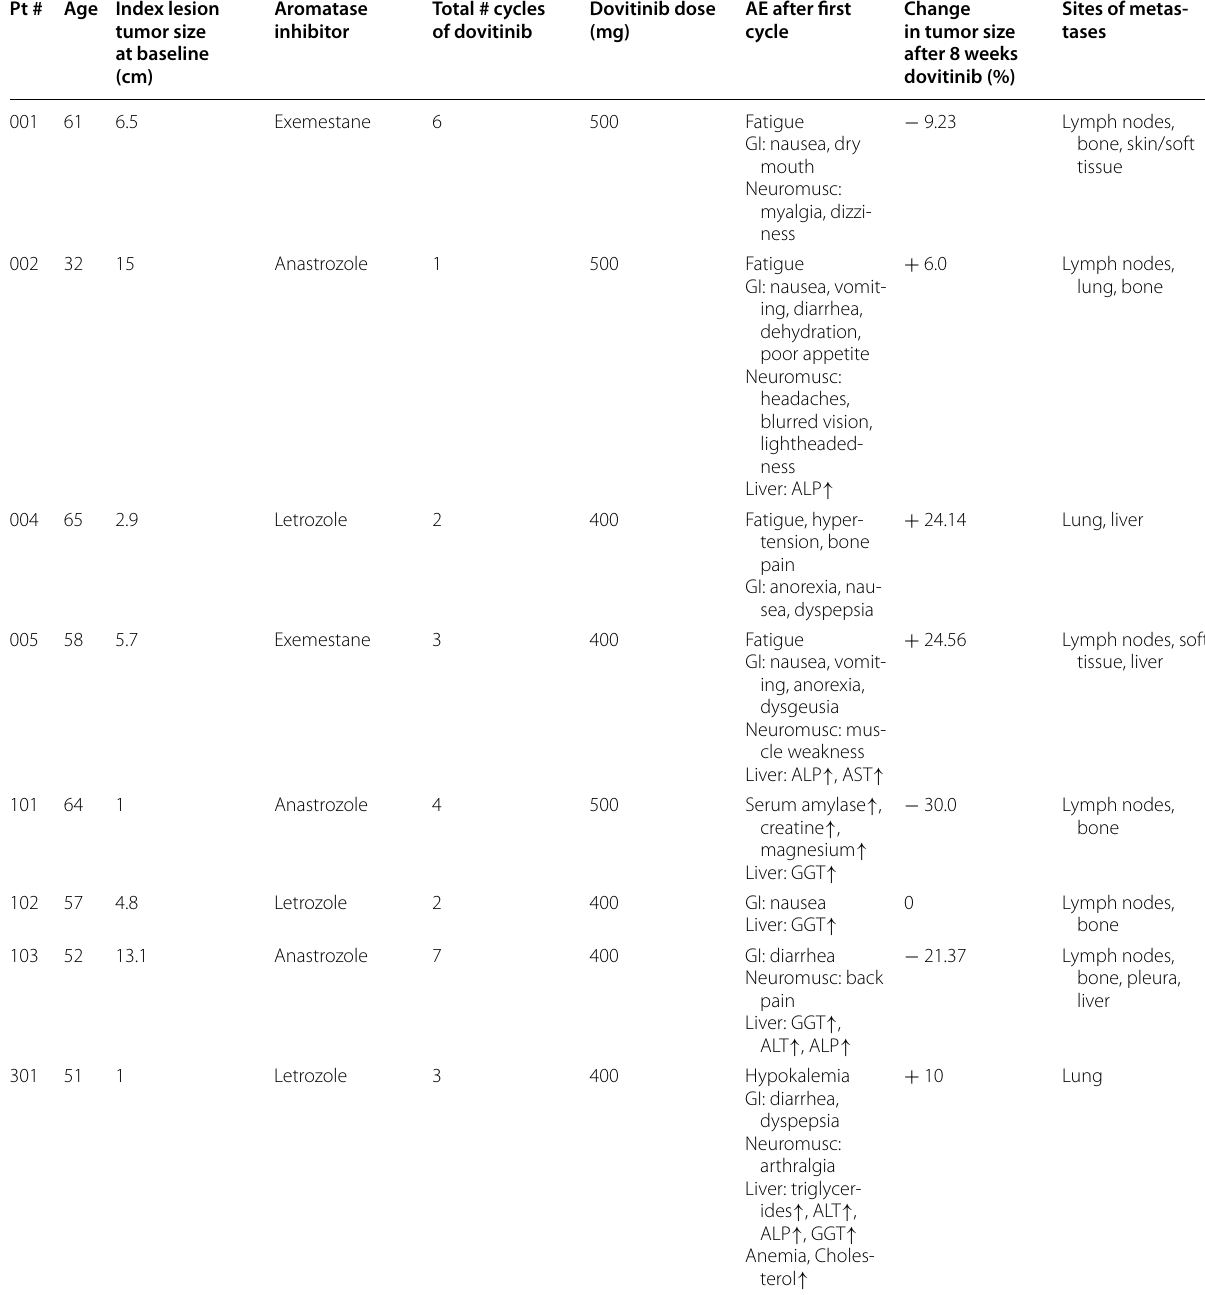
Table 1 Patients with hormone positive metastatic breast cancer treated with dovitinib Pt # Age Index lesion tumor size at baseline